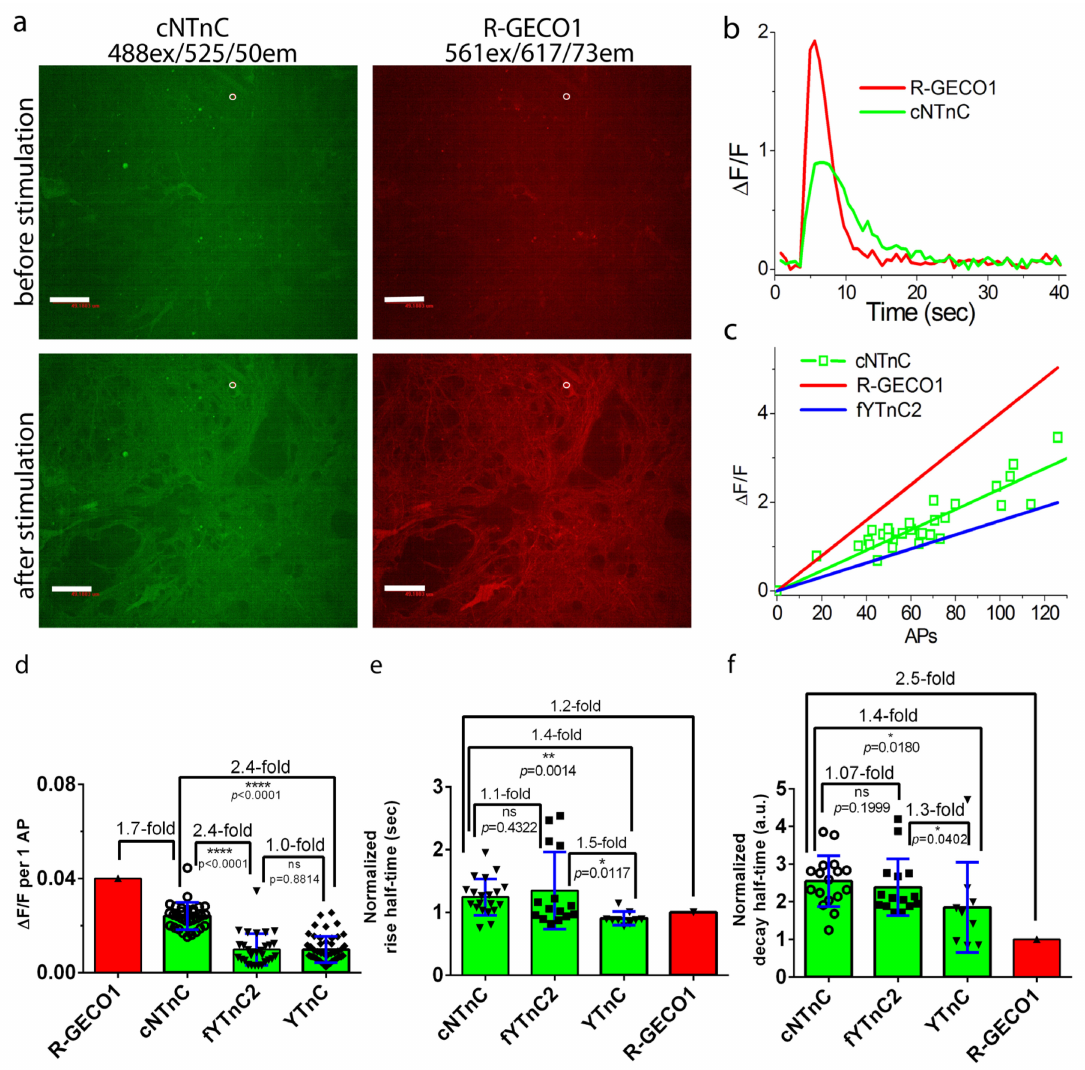
Figure 6. Comparison of the responses of green cNTnC and red R-GECO1 indicators to the external field stimulation of neurons coexpressing GECIs in dissociated neuronal cultures. Neuronal cultures coexpressing the NES-cNTnC and NES-R-GECO1 indicators were imaged and stimulated on DIV 21–22. Neuronal cultures were transduced on DIV 4 with a mixture of rAAVs carrying NES-cNTnC and NES-R-GECO1. ( a ) Confocal images of neuronal culture coexpressing the NES-cNTnC and NES-R-GECO1 indicators before (top) and after (bottom) electrical stimulation. Scale bar, 50 µ m. ( b ) The graph illustrates ∆ F/F changes in the green and red fluorescence of the cNTnC and R-GECO1 indicators in response to electrical field stimulation. The changes on the graph correspond to the area indicated in Panel a as a white circle. ( c ) The dependence of ∆ F/F responses of the cNTnC indicator vs. the number of action potentials (APs). The number of APs was determined according to the ∆ F/F response of the R-GECO1 indicator (0.04 per 1 AP) coexpressed in the same cell and assuming that the response’s linearity in the examined AP range (linear fitting for cNTnC had R2 value of 0.89935). The dependences of ∆ F/F responses on APs for fYTnC2 and R-GECO1 were added to compare the results. ( d ) The ∆ F/F responses per AP for cNTnC and fYTnC2 were calculated according to the ∆ F/F response of R-GECO1 (0.04 per 1 AP) in the same cell. For comparison, the ∆ F/F response per AP for YTnC was added from previous work [11]. ( e , f ) The rise ( e ) and decay ( f ) half-times of cNTnC and fYTnC2. ( d – f ) Error bars are the standard deviations across 31–49 cells. Ns, not significant, p > 0.05. *, p value is from 0.01 to 0.05. **, p value is from 0.001 to 0.01. ****, p <